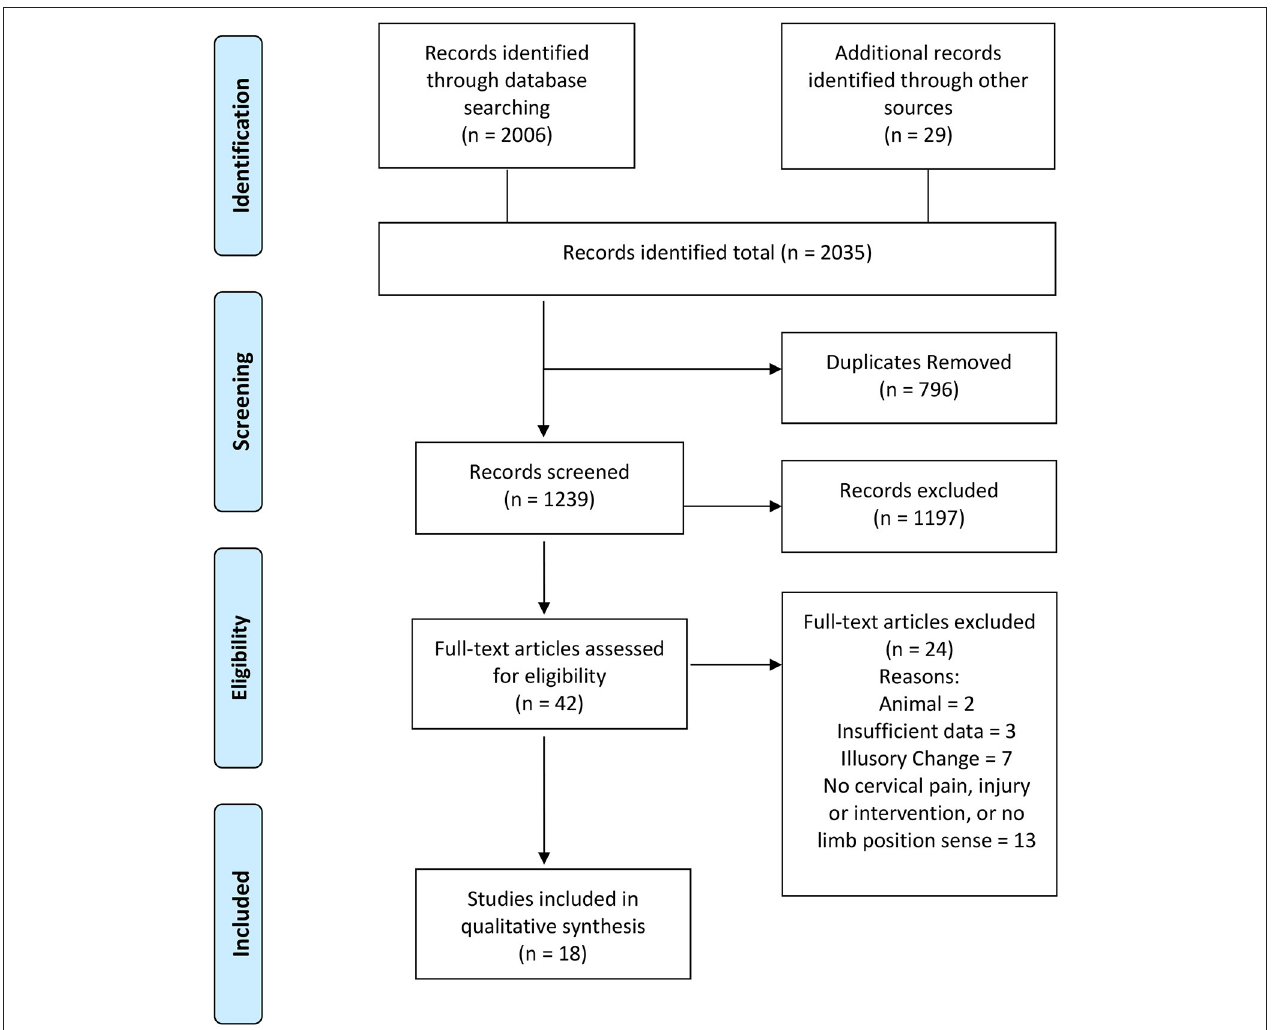
FIGURE 1 | PRISMA flow diagram. Adapted from Moher et al. (17).